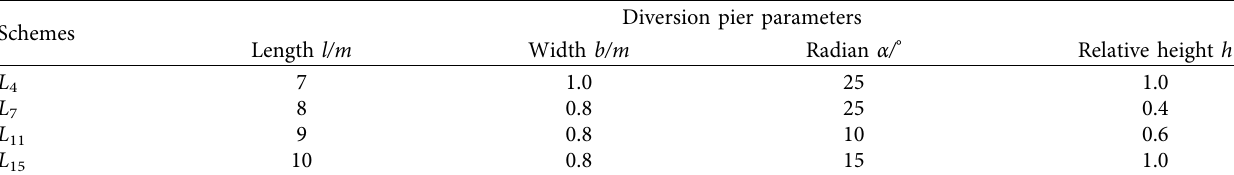
Table 5: Typical calculation scheme of the numerical